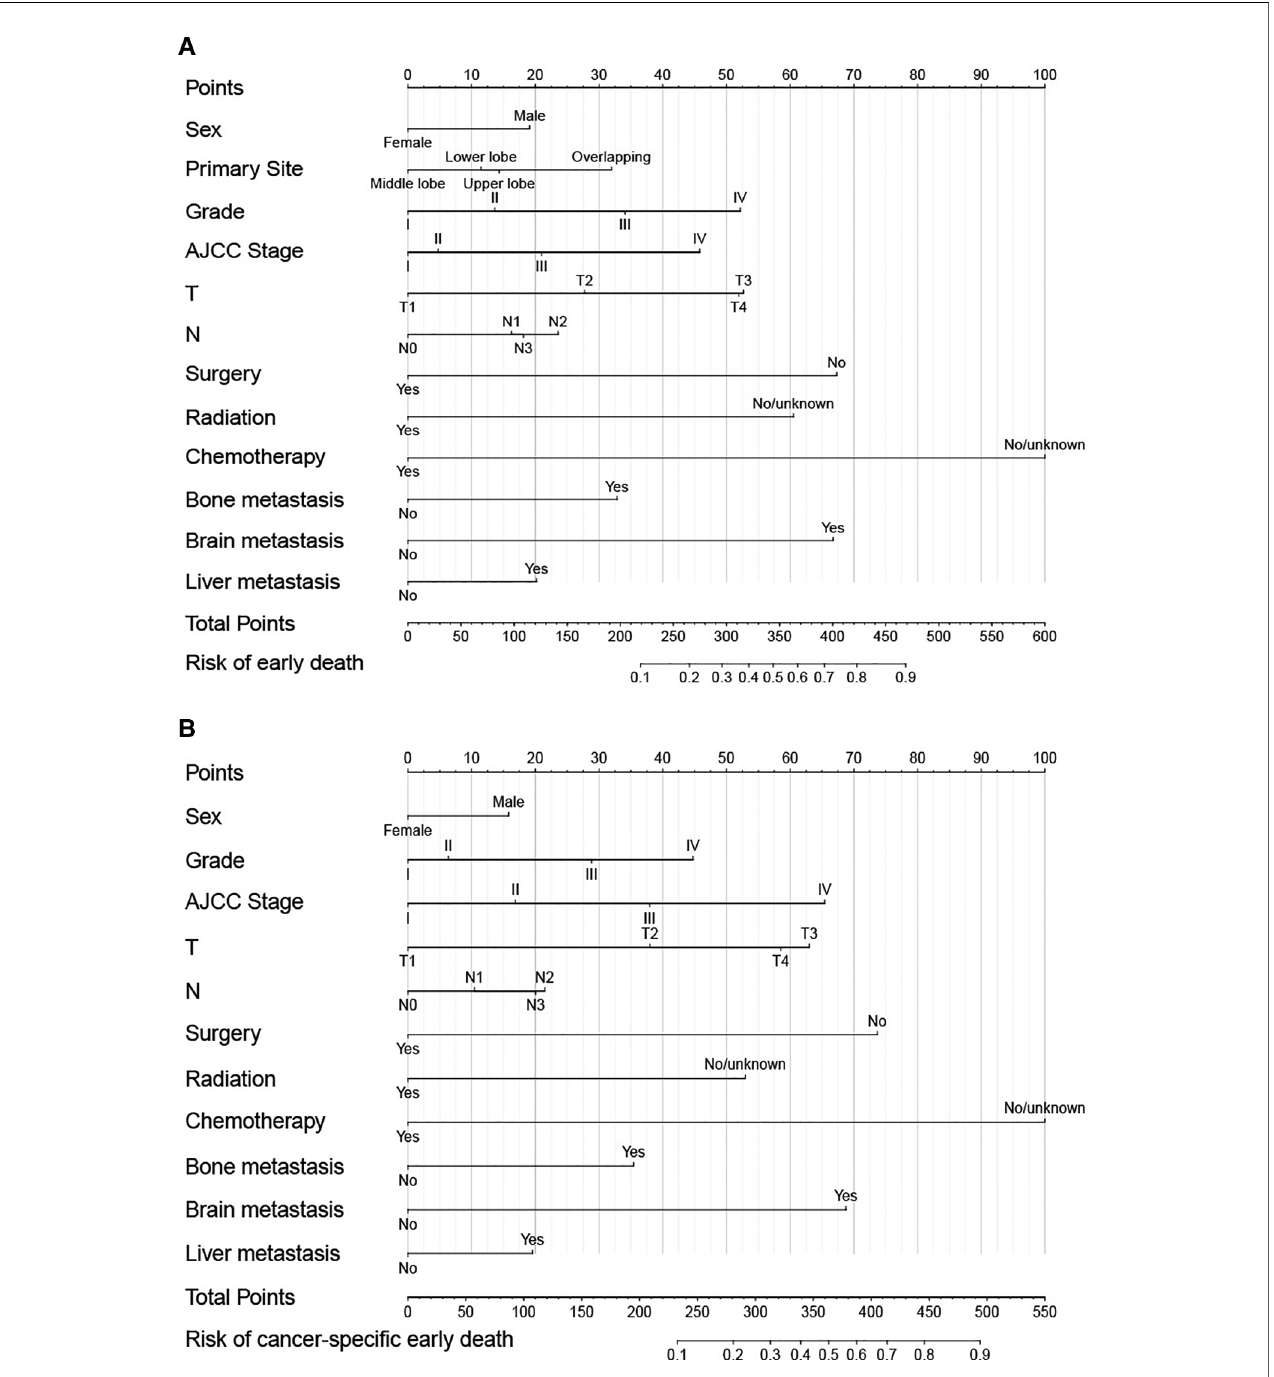
FIGURE 1 Nomograms for predicting all-cause ( A ) and cancer-speci fi c early death ( B ) in elderly LC